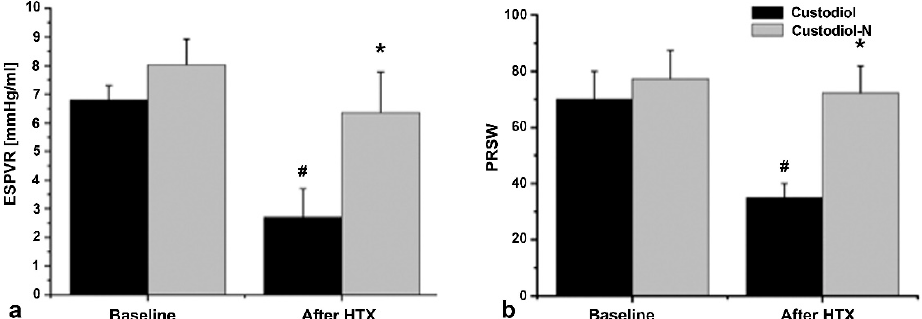
Figure 1. Hemodynamics (Series 1: 4 h conservation time). ( a ) End-systolic pressure–volume relationships (ESPVR); ( b ) preload recruitable stroke work (PRSW). Values given as mean ± SEM. * p < 0.05 vs. control, # p < 0.05 vs. corresponding baseline. n = 8 in each experimental group.